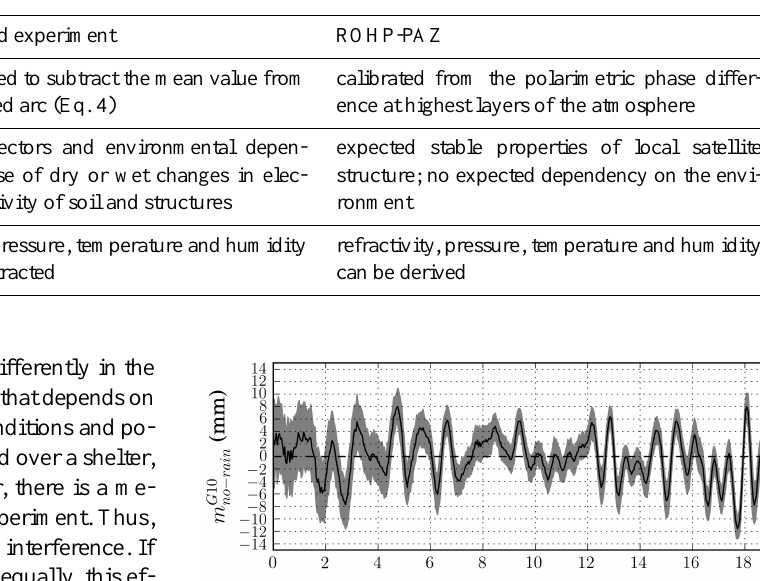
(cid:12) (cid:12) ((cid:15)) (cid:12) day observed